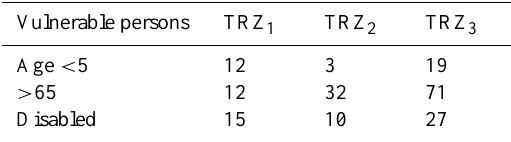
Table 6. Number of buildings with vulnerable indicators in the TRZ i ( i = 1 , 2 ,